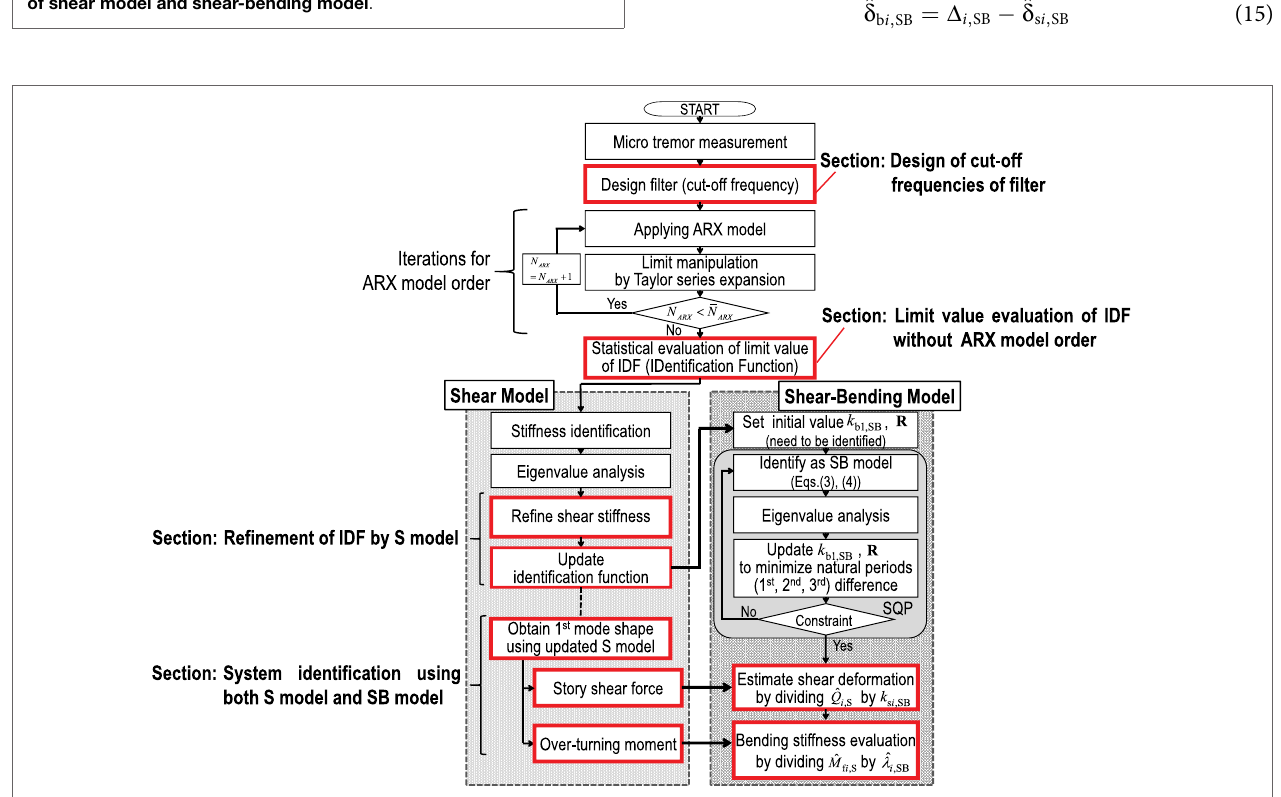
FIGURE 8 | Flowchart of stiffness identification using both S model and SB model